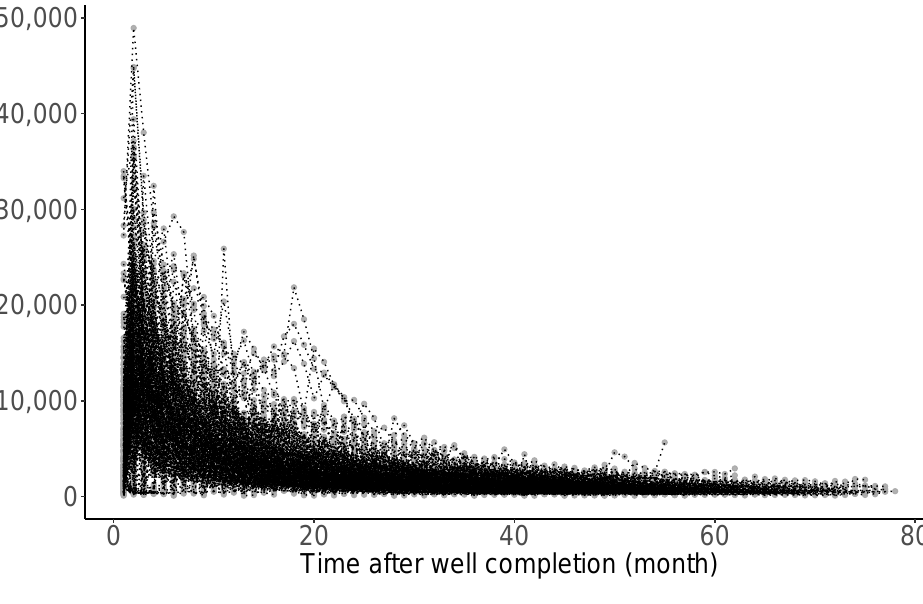
Figure 4. Production rates for 360 shale oil wells after completion.